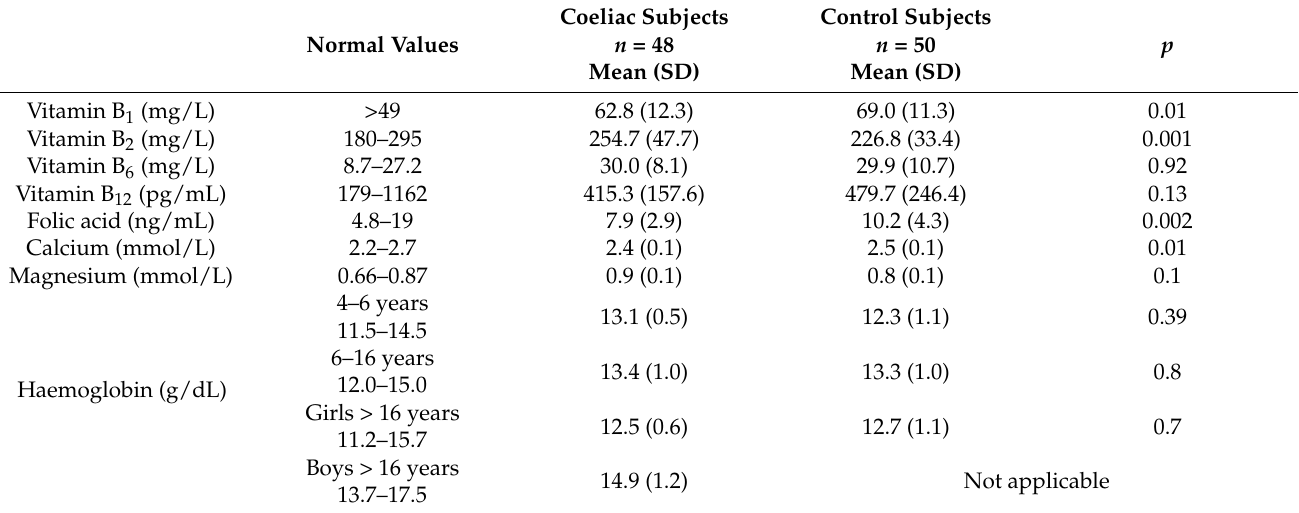
Table 3. Mean haemoglobin level and serum values of the selected micronutrients in CD and non- CD